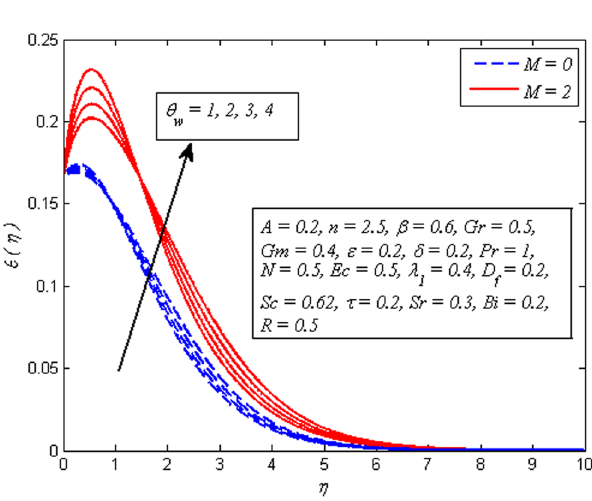
Figure 12. Effect of Pr on temperature for different A .